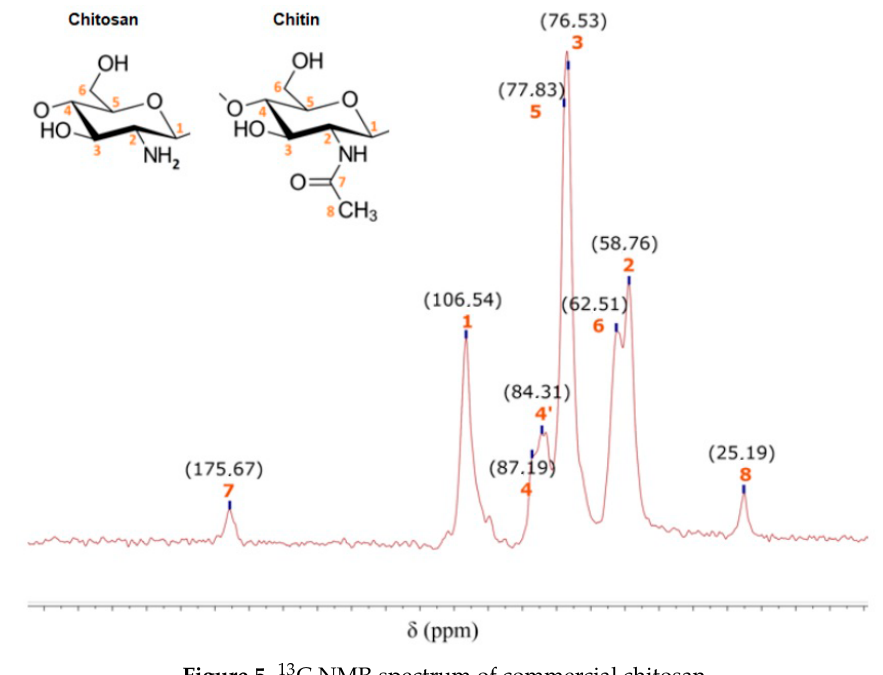
Figure 5. 13 C NMR spectrum of commercial chitosan.